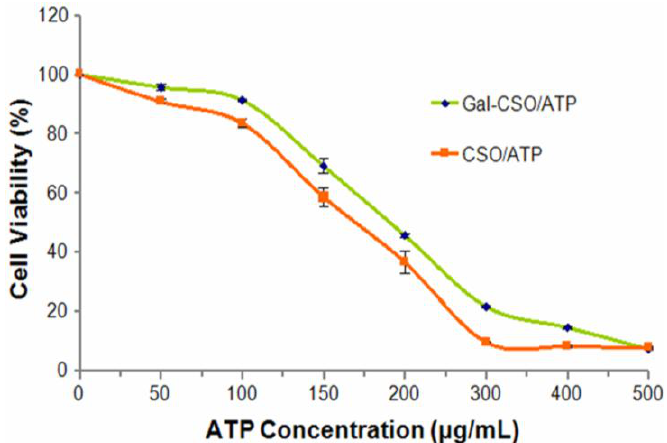
Figure 6. Cell viability % of HepG2 cells after incubation with Gal-CSO/ATP and CSO/ATP for 48 h, respectively. Cytotoxicity was evaluated by the methyl tetrazolium (MTT) assay. Data represent the mean ± standard deviation ( n =